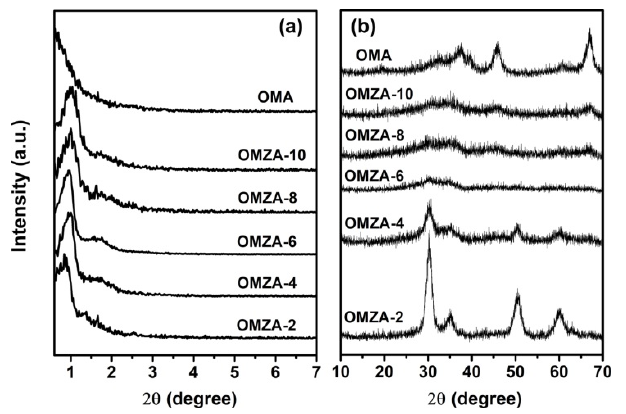
Figure 8. Small- ( a ) and wide- ( b ) angle XRD patterns of samples OMZA-x and OMA after thermal treatment at 1000 °C for 1 h. Table 2. The textural properties of OMZA-x and OMA thermally treated at 1000 ◦ C for 1 h. a